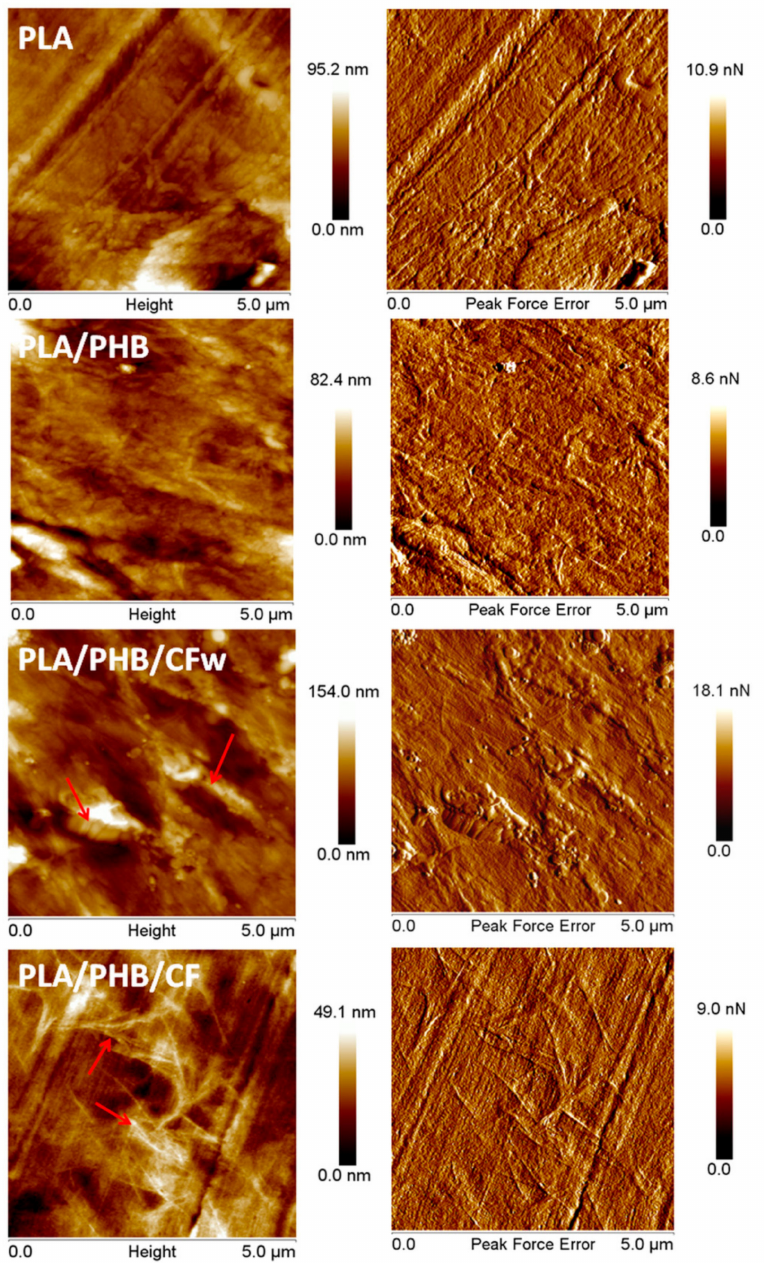
Figure 8. Topographic and PFE images of PLA, PLA/PHB, and biocomposites. Several light-colored objects, like that in the bottom right corner in Figure 8–PLA, were observed on the surface of PLA, which is a commercial product containing additives (fillers, nucleating agents, residual catalyst) [55]. The channels and stripes observed on